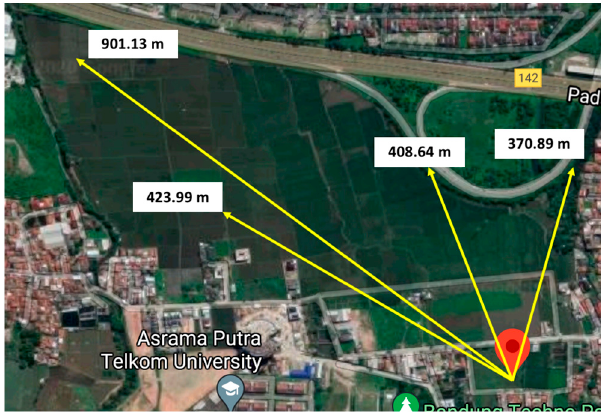
Figure 12. LoS Tracking Scenario.